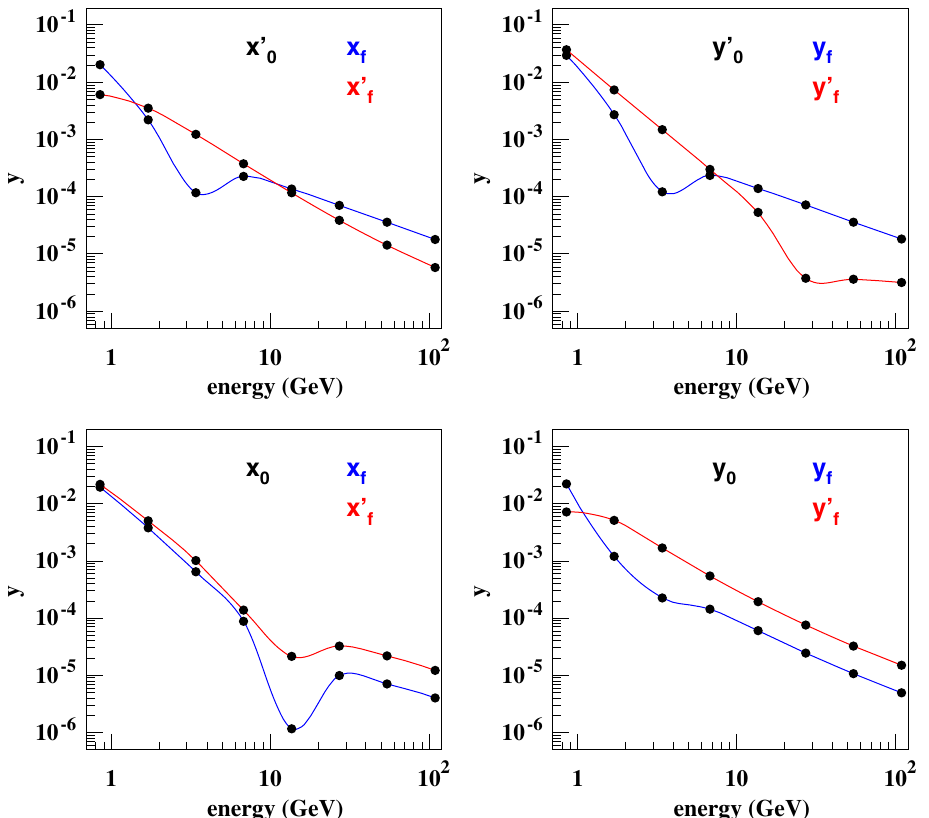
We started from the model 3D quadrupole depicted in Fig. 2 including 12 Fourier coefficients. This quadrupole has an integrated strength of 2 . 12 = m (normalized to the particle energy). In order to move the tune close to a quarter resonance, all Fourier coefficients and also the strength of the two kick quads are multiplied by the same factor afact ¼ 2 . 27 . The orbit displacement versus turn number in